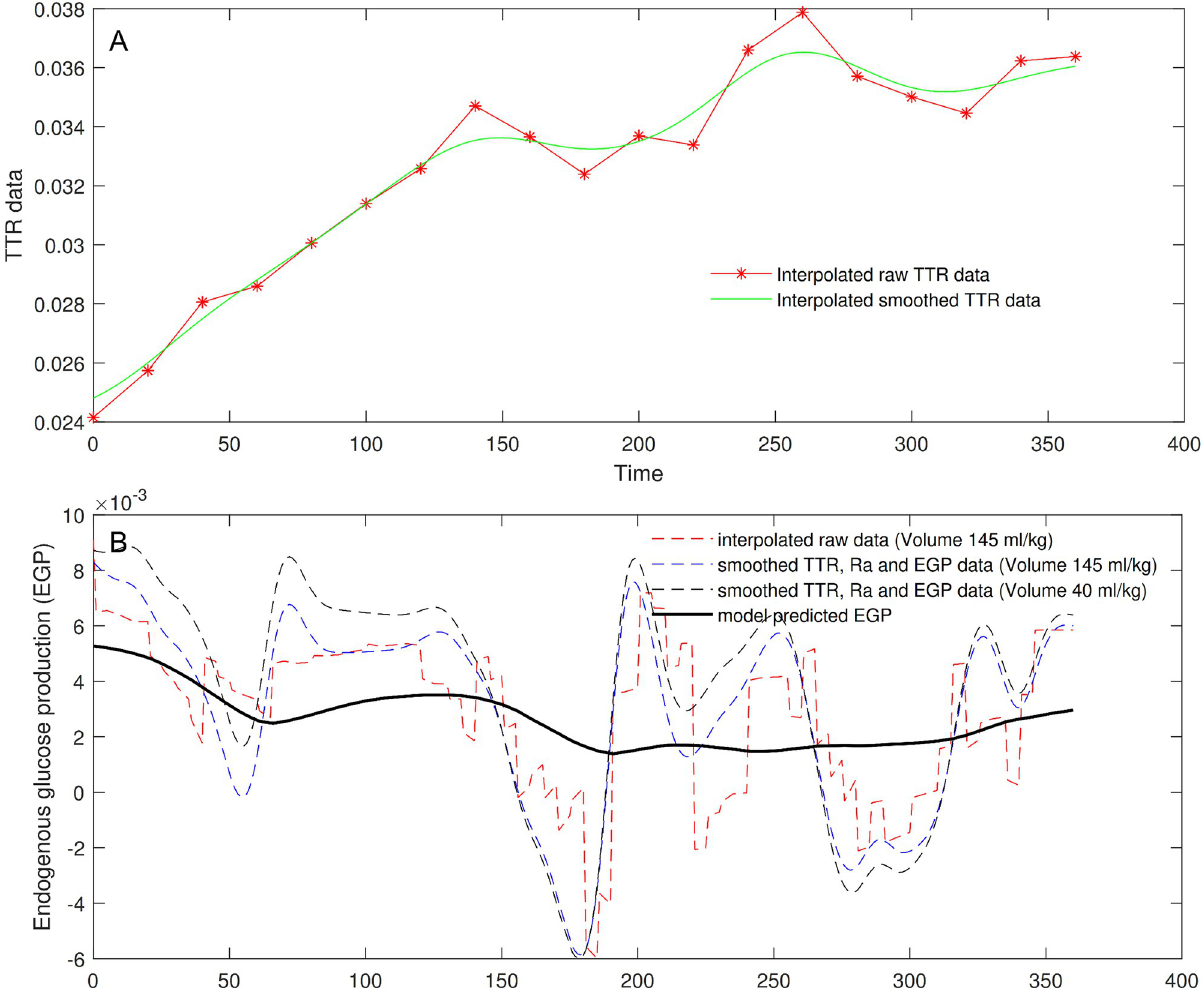
Fig 2. Endogenous glucose production. TTR data (Panel A), only interpolated (dashed red line) and smoothed (continuous green line); EGP computation from the equation of Steele in case TTR data are smoothed and in case they are only interpolated (Panel B). Four different trends of EGP were computed using not smoothed (dashed red line) or smoothed (blue and black dashed lines) TTR data with different glucose distribution volumes (145 ml/kg or 40 ml/kg, respectively), and derived by the model predictions (continuous black